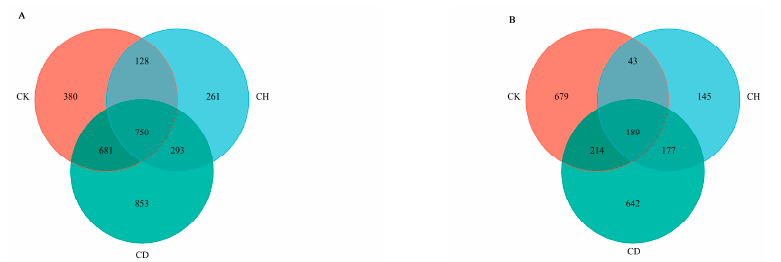
Figure 4. Venn diagrams of bacterial and fungal OTUs in the three soil samples. ( A ) Venn diagram of bacterial OTUs. ( B ) Venn diagram of fungal OTUs. CH—biennial ginseng seedlings that were transplanted and then continuously cropped for four years in healthy ginseng rhizosphere woodland soil, CD—biennial ginseng seedlings that were transplanted and then continuously cropped for four years with severe soilborne disease in ginseng rhizosphere woodland soil, CK—soil sample from woodland without ginseng planting.